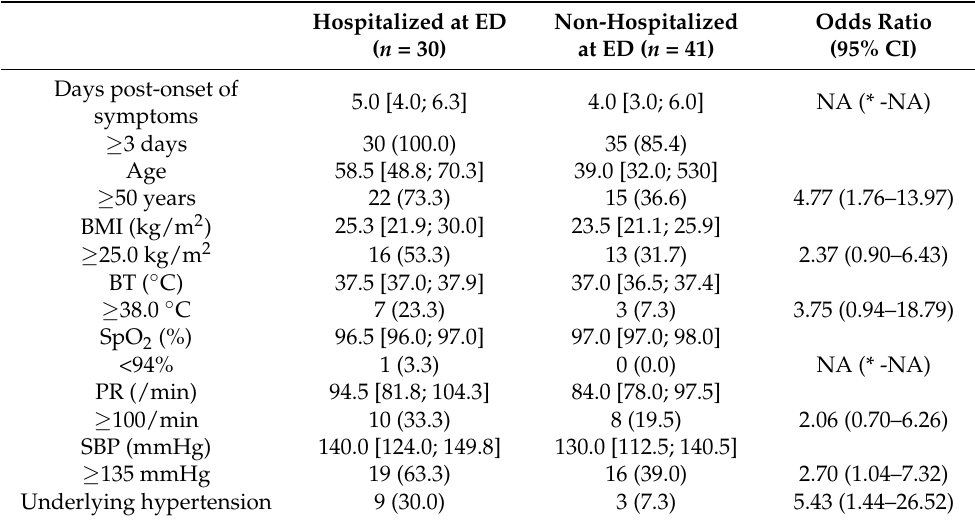
Table 4. Checklist factors associated with hospitalization following ED visits during